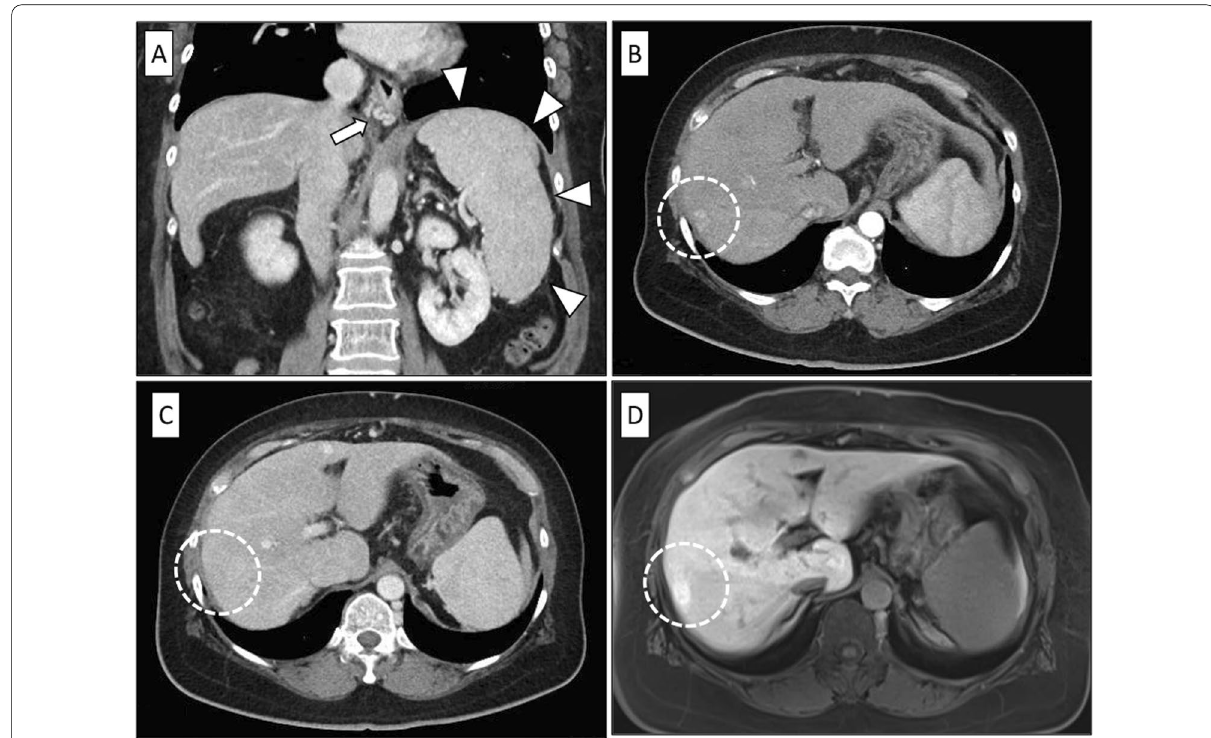
Fig. 1 A Contrast-enhanced computed tomography showing esophageal varices (arrow) and splenomegaly (arrowheads). B Contrast-enhanced computed tomography of early phase showing a mass lesion with early enhancement (circle). C Contrast-enhanced computed tomography of portal phase showing a mass lesion without contrast agent wash out (circle). D EOB- magnetic resonance imaging of hepatocellular phase showing a mass lesion without contrast agent wash out